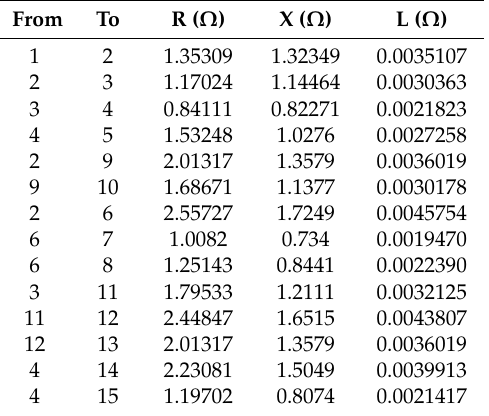
Table 1. IEEE 15 Bus System Load Data.